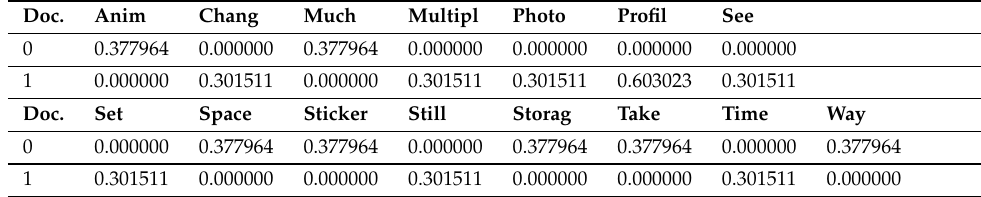
Table 9. The results of TF-IDF on sample reviews.